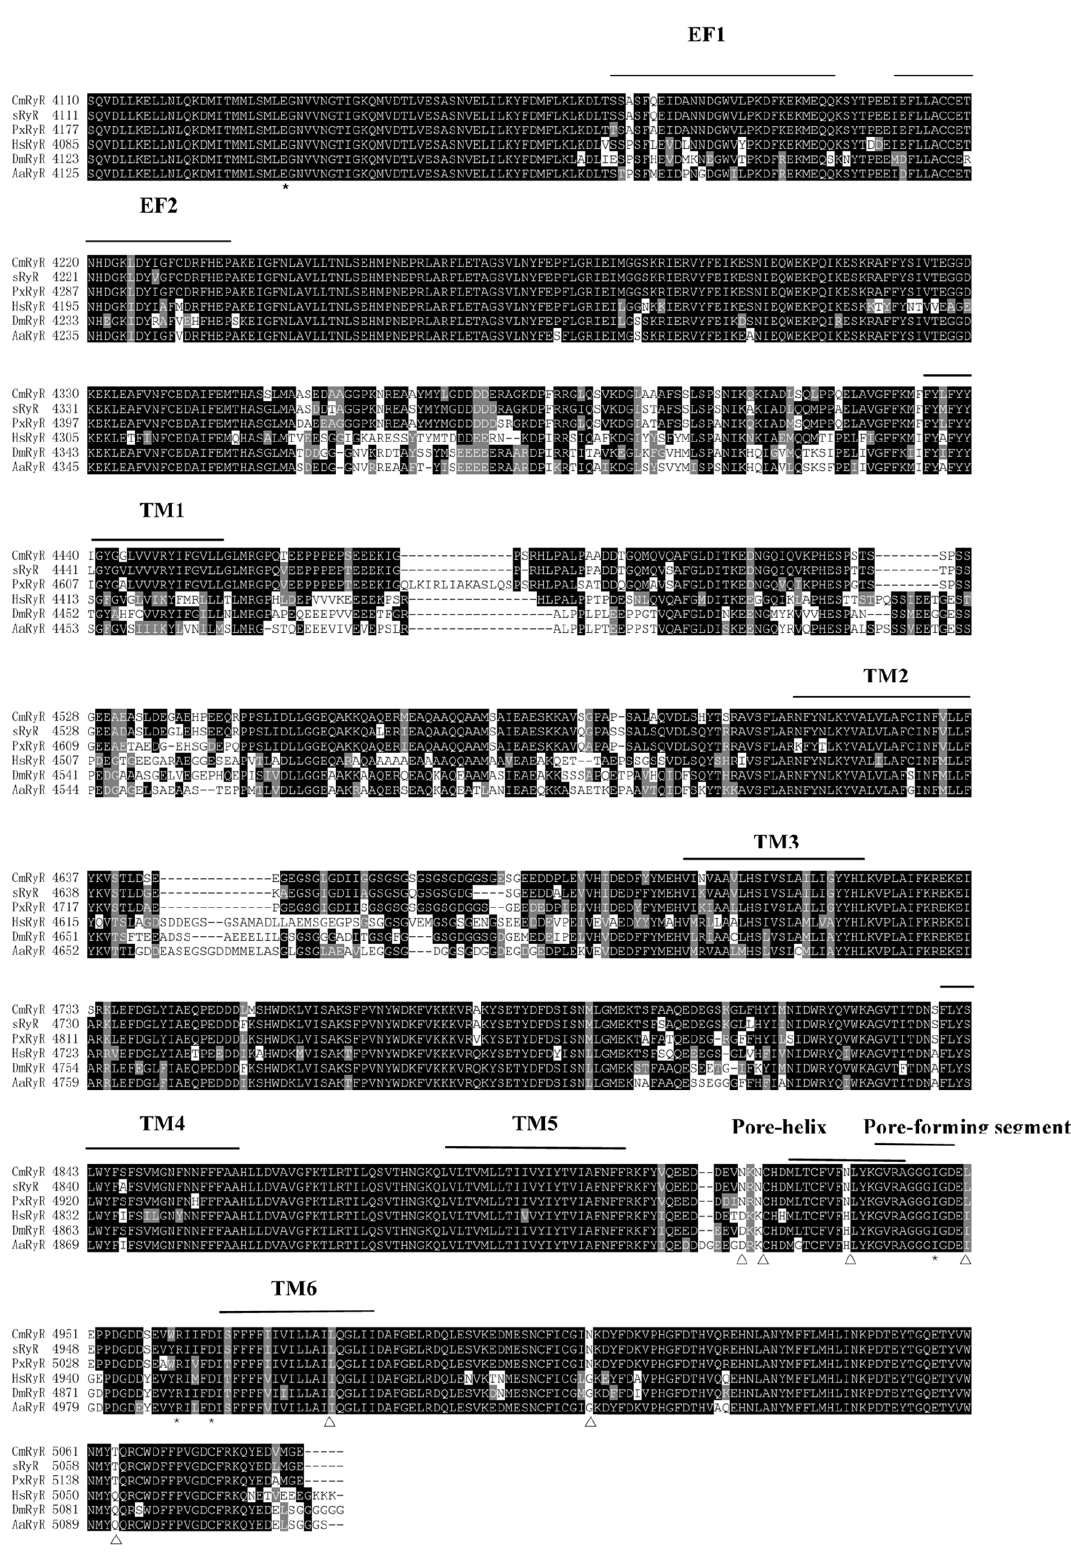
Figure 4. Alignment of COOH-terminal region of the insect RyR isoforms. Identical amino acids are shown in black boxes and similar amino acids are highlighted in gray boxes. Gaps have been introduced to permit alignment. Asterisks below the alignment indicate the position of residues discussed in the text (E 4134 , I 4946 , R 4962 , and D 4966 of CmRyR). Triangles below the alignment indicate unique residues (N 4922 , N 4924 , N 4935 , L 4950 , L 4981 , N 5013 and T 5064 of CmRyR) in the lepidopteran homologues. Abbreviations and GenBank entries for the RyR isoforms are described in Figure 2.